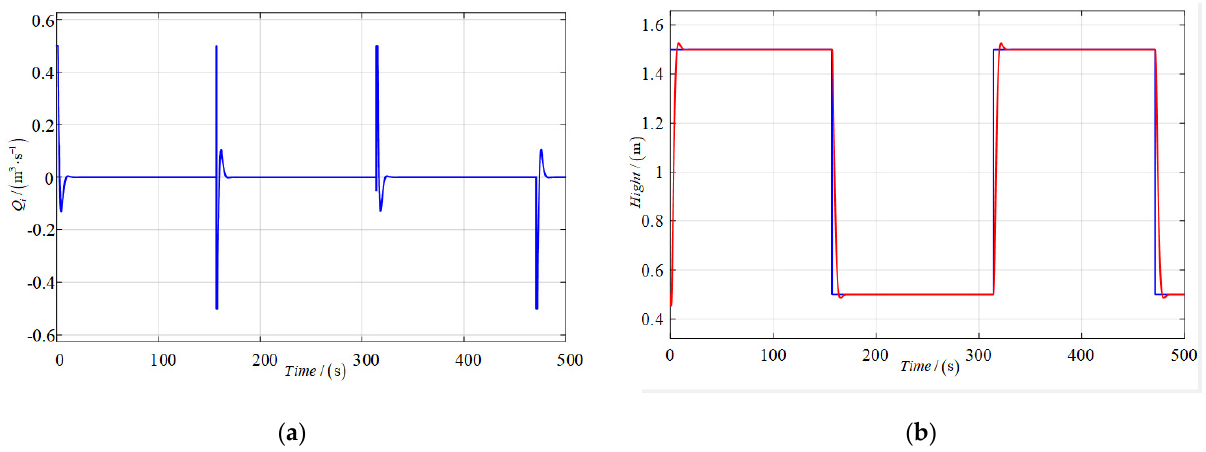
Figure 6. Simulation results of nonlinear decorated robust controller: ( a ) represents the control input curve ( b ) represents the water level curve.